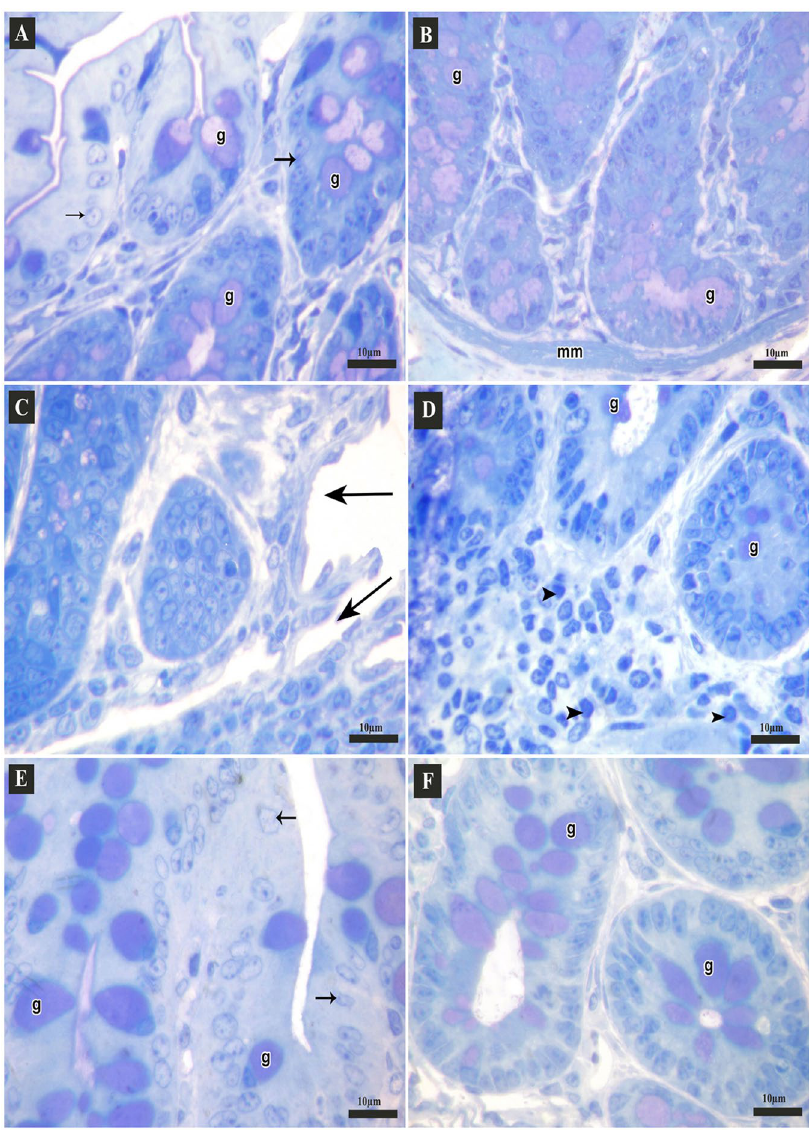
Figure 5. Semi-thin sections of the colon of adult male mice (Toluidine blue stain, 1000x). ( A,B : Control group A ) Apical parts of the mucosa; columnar cells (arrows) and many goblet cells (g) that may open into the lumen. ( B ) Basal parts of the crypts lined with many goblet cells (g), muscularis mucosa (mm). ( C , D : DSS group C ) Apical parts of mucosa with mucosal ulcers (arrows). ( D ) Basal parts of the crypts; few goblet cells (g), diffuse inflammatory cell infiltrations (arrow heads). ( E,F : DSS + AuNPs group E ) Apical parts of the mucosa, columnar cells (arrows), many goblet cells (g). ( F ) Basal parts of the crypts, many goblet cells